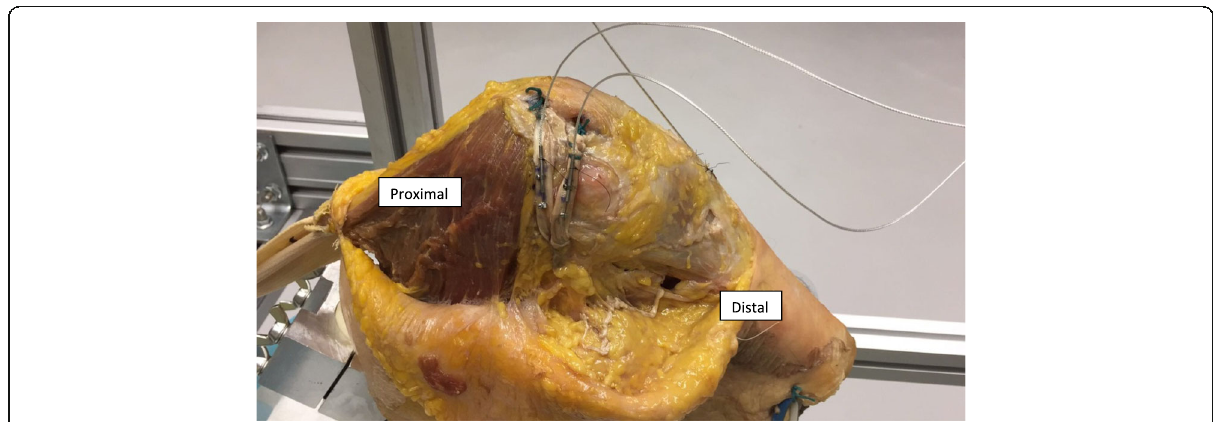
Fig. 4 DVRT attached to double bundle reconstructed MPFL of left knee mounted onto the